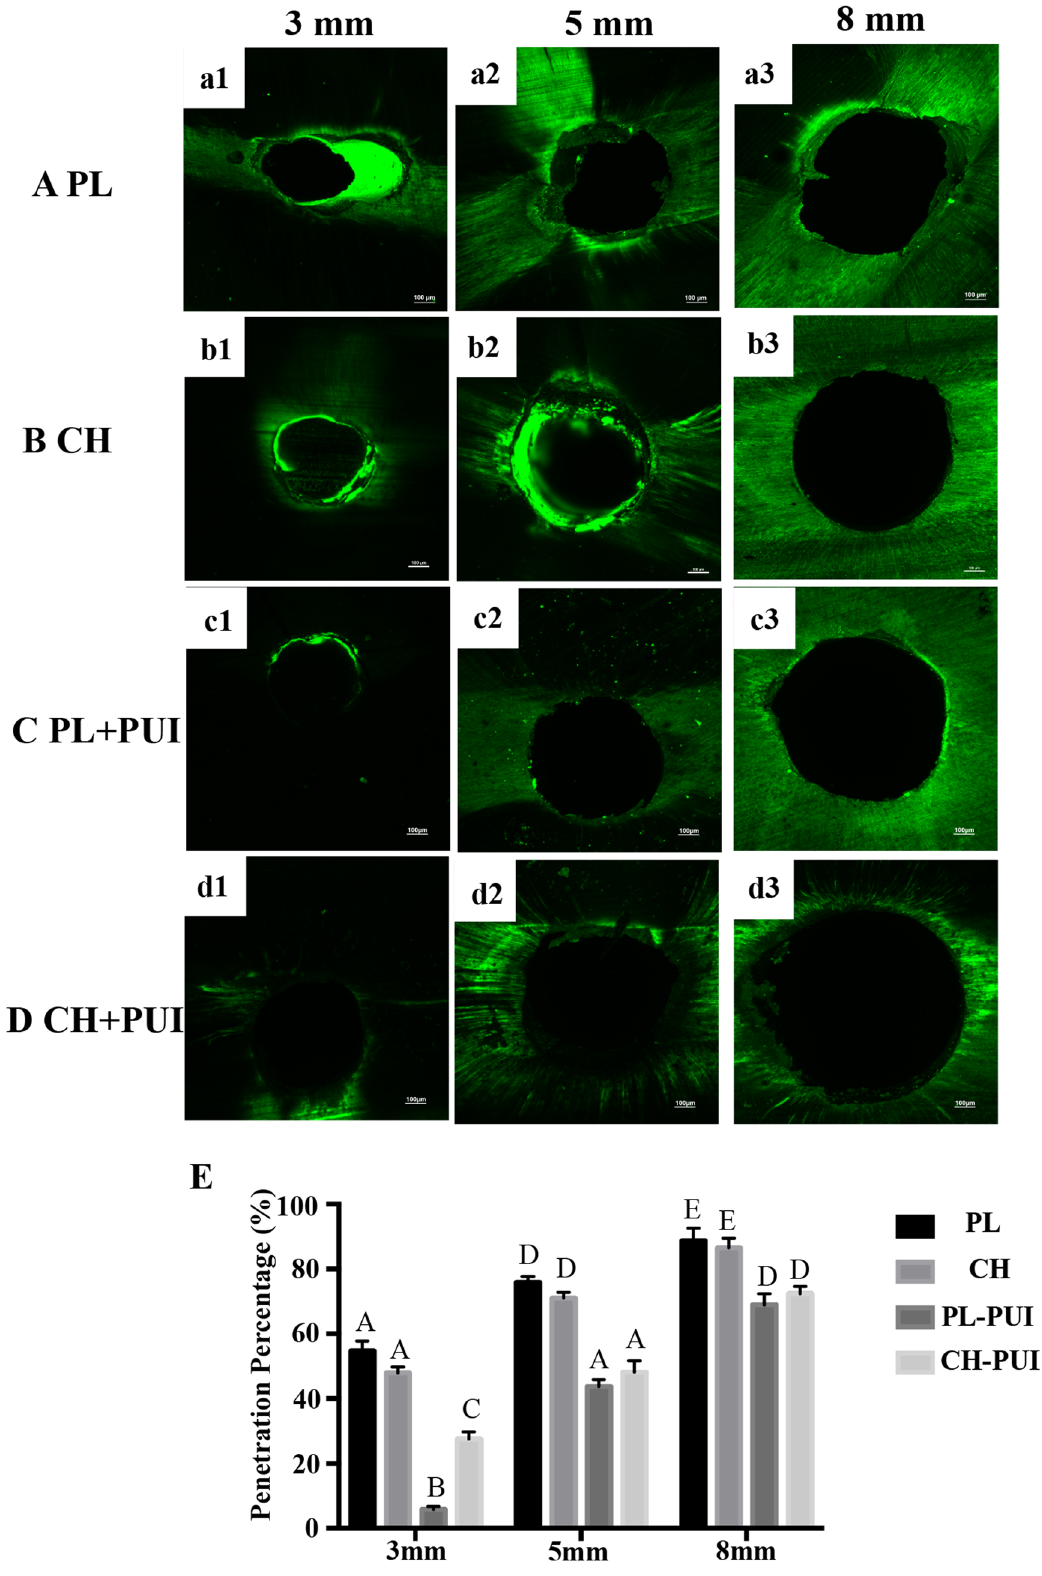
Figure 9. Representative confocal laser scanning microscopic images from each group at coronal, middle and apical thirds: ( a1 – a3 ) PL group; ( b1 – b3 ) CH group; ( c1 – c3 ) PL-PUI group; ( d1 – d3 ) CH-PUI group (scale bar: 100 μm); ( d ) Penetration percentage of the PL and CH into the dentinal tubules in all experimental groups. Significant differences between columns are labelled by different upper-case letters ( P <